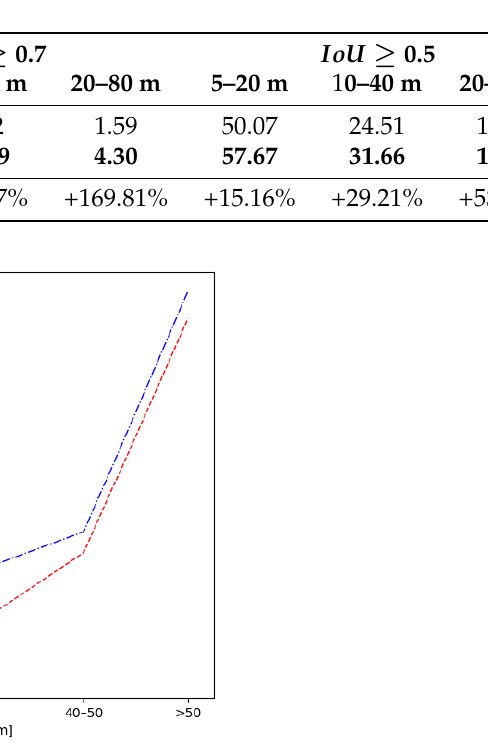
Figure 11. The average error of depth prediction visualized in different depth